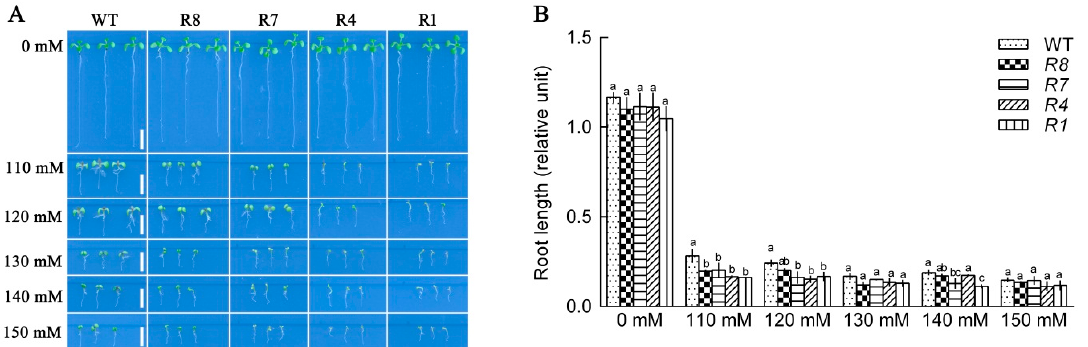
Figure 3. Down-regulation of CPK12 results in NaCl-hypersensitive root growth. ( A ) Seeds were planted in NaCl-free (0 mM) medium or media containing 110, 120, 130, 140, 150, or mM NaCl, and root growth was detected 10 days after stratification. Scale bars, 0.5 cm. ( B ) Root lengths are mean ± standard error from three independent experiments. Thirty plants were measured for each genotype in each treatment. The mean values of root lengths are labeled with letters in the same group to denote significant differences ( p < 0.05).